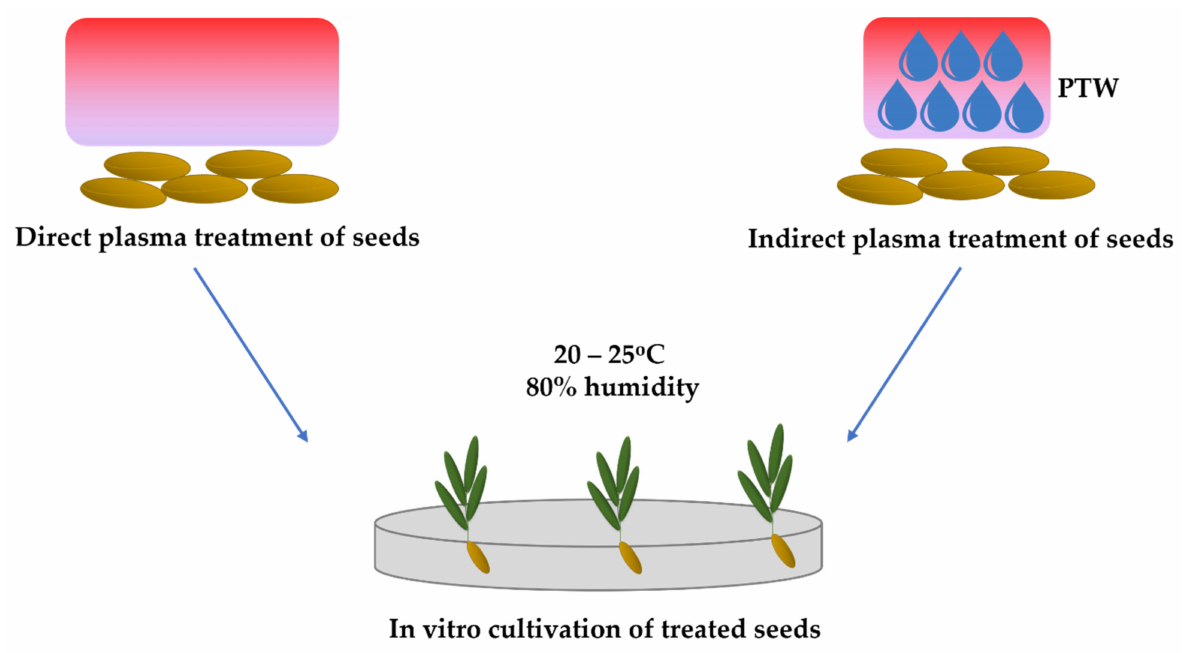
Figure 5. Direct ( left ) versus indirect ( right ) treatment of seeds using cold